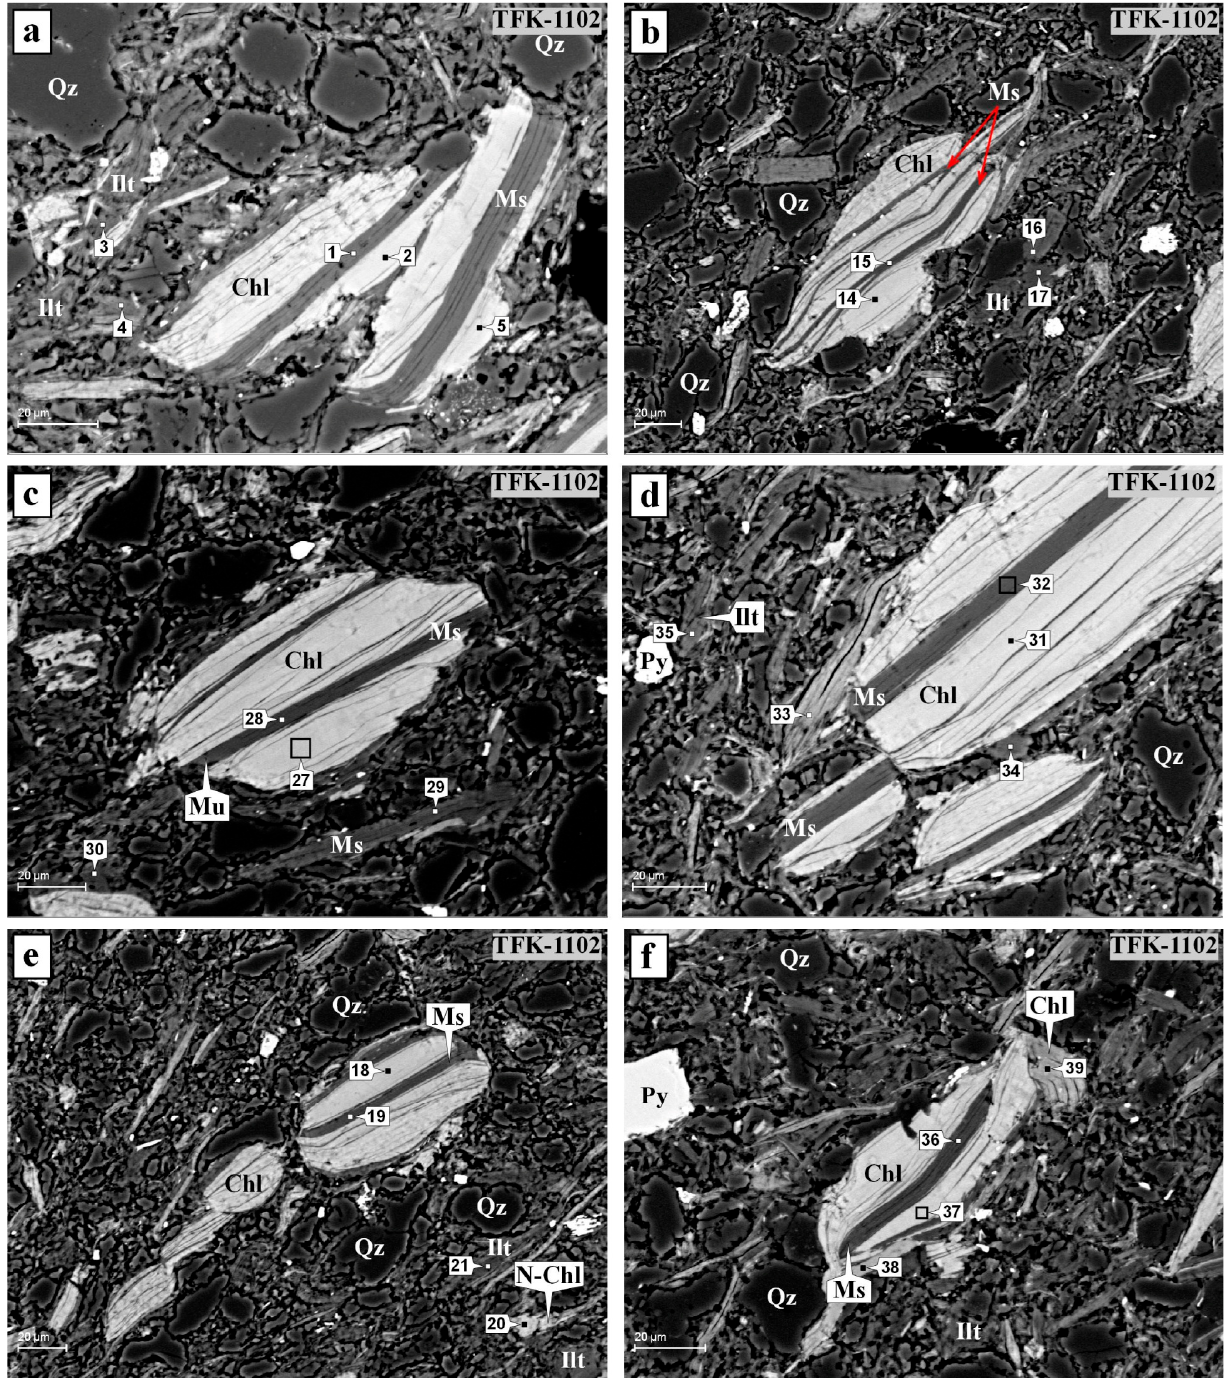
Figure 7. SEM-BSE photomicrographs of the late Ordovician silty slate with locations of some analyzed points and areas (black rectangulars). ( a ) Elongated chlorite-rich CMS which their stacking planes nearly parallel to bedding planes within the groundmass, including neoformed illites and chlorites, ( b , c ) Lozenge-shaped and curved chlorite-rich CMS, ( d , e ) Elongated chlorite-rich CMS, their long axes are parallel to bedding planes and sliced by crenulation type of cleavage planes in the quartz-fine grained-white K-mica and chlorite groundmass, ( f ) Elongated and curved chlorite-rich CMS within the groundmass containing pore filled neoformed illites and